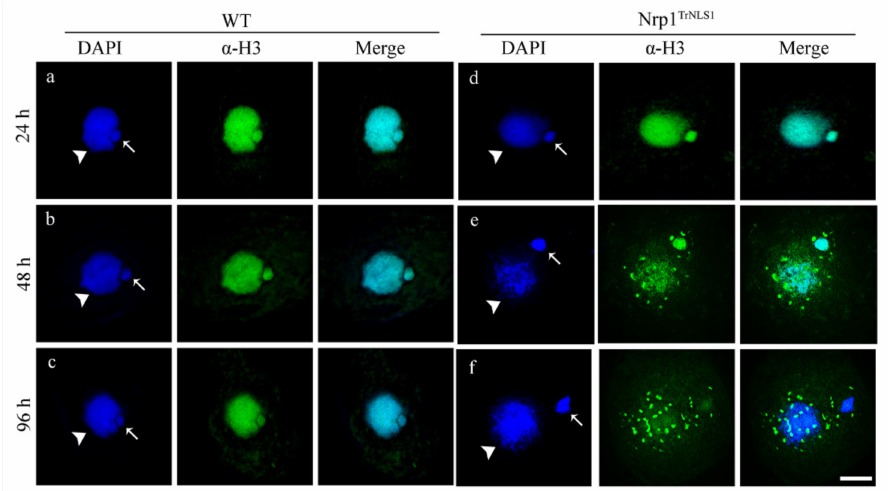
Figure 3. Overexpression of Nrp1 TrNLS1 affects H3 nuclear import. Indirect immunofluorescence localization of H3. The WT ( a – c ) and Nrp1 TrNLS1 ( d – f ) mutant cells were induced with 0.3 µ g/mL Cd 2+ for 24, 48, and 96 h. The primary antibody was histone H3 rabbit polyclonal antibody, and the secondary antibody was FITC-conjugated goat anti-rabbit. Arrows indicate MIC, arrowheads indicate MAC. Scale bar, 10 µ